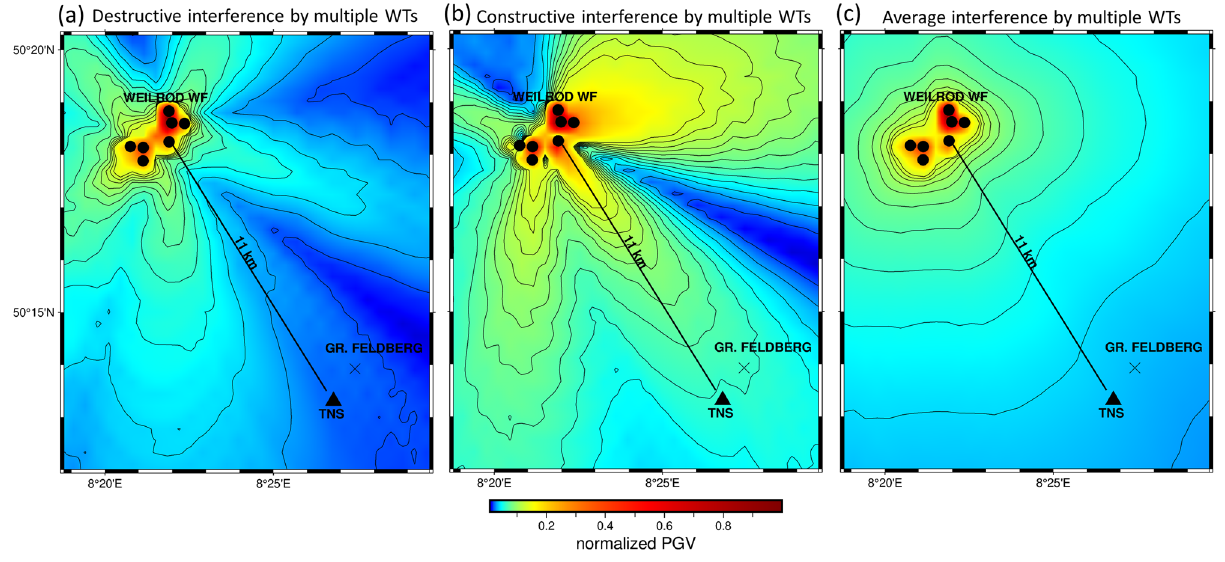
Figure 4. The specific destructive ( a ) and constructive ( b ) interference of the wavefields produced by multiple WTs results in low and high normalized PGVs, respectively, at TNS. The interference (radiation) pattern in ( c ) is obtained by averaging 100 PGV maps calculated with a randomly chosen phase for each source time function of the 7 sources. Topography is not included here. The amplitudes are normalized to the maximum amplitude that occurs and is therefore 1 at the source location.